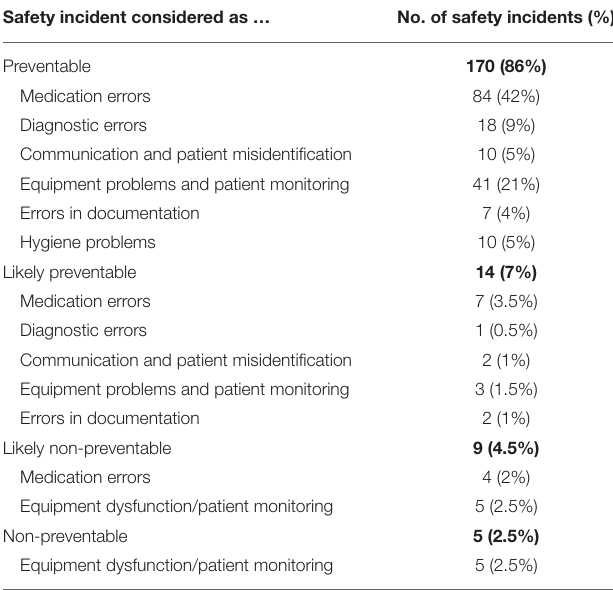
TABLE 3 | Estimation of preventability of safety